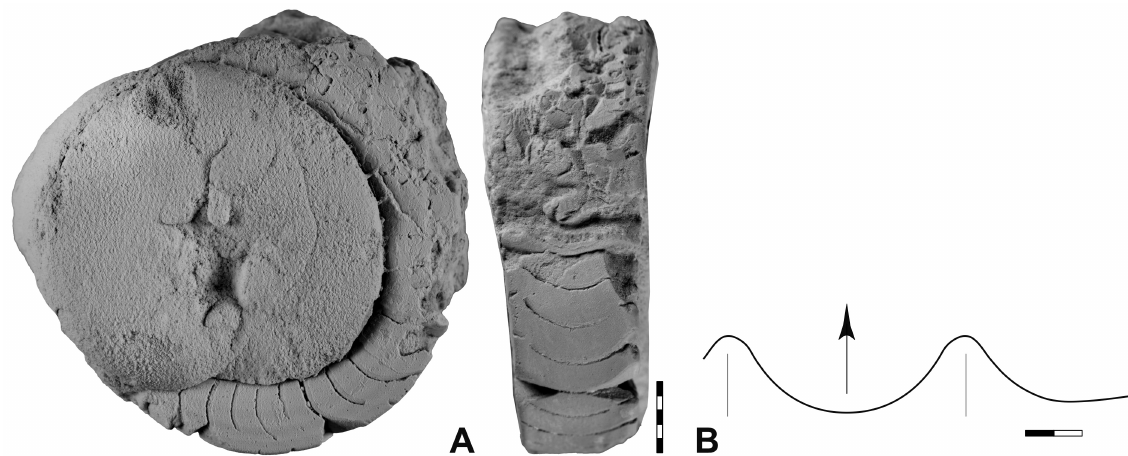
Fig. 9. Stroborineceras sp. from Oued Temertasset, specimen MB.C.30455 (Korn et al . 2002 Coll.). A . Lateral and ventral views. B . Suture line, at ww = 9.4 mm, wh = 6.6 mm. Scale bar units = 1